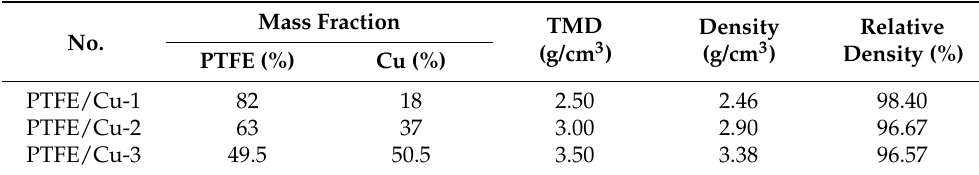
Table 1. Mass fraction and density of PTFE/Cu: PTFE: polytetrafluoroethylene; TMD: theoretical maximum